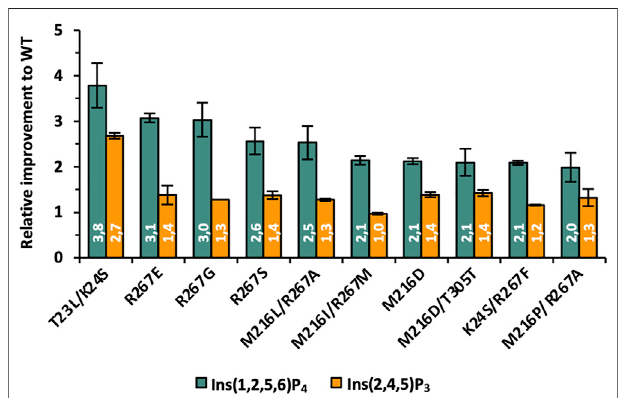
FIGURE 5 | Relative improvements of best variants identi fi ed during phase II of KnowVolution. All improvements are adjusted to protein